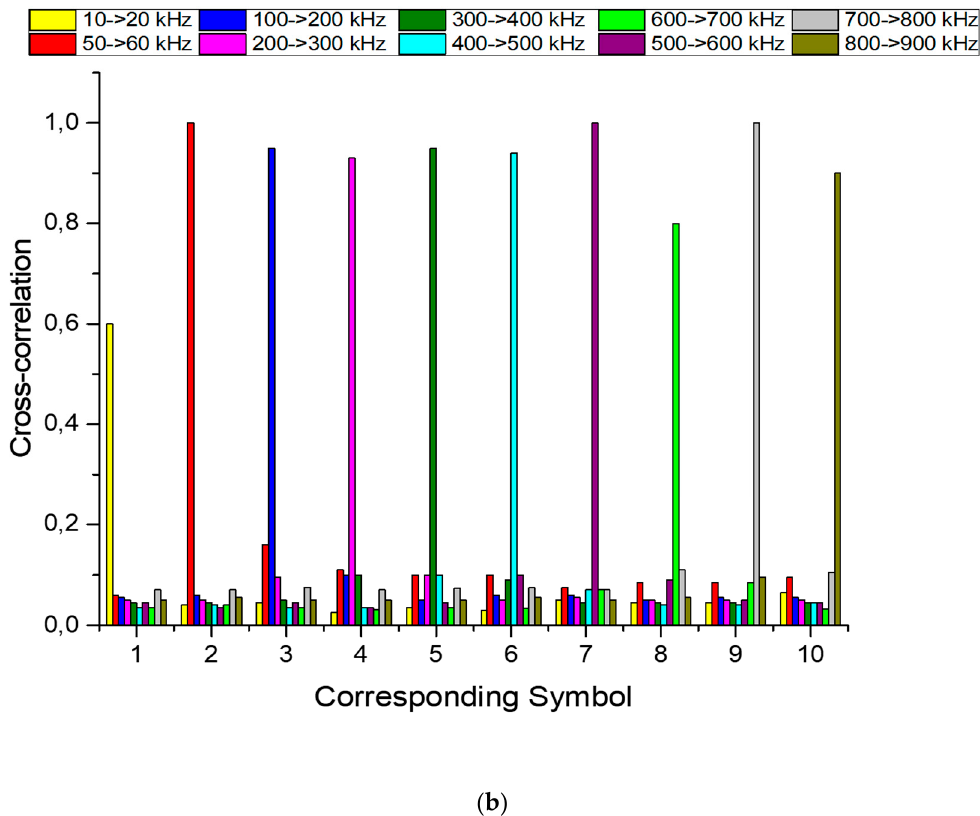
Figure 12. Cross-correlation result for the 10 chirp signals transmitted with the 10 chirp samples at: ( a ) 1 m distance and ( b ) 15 m distance.